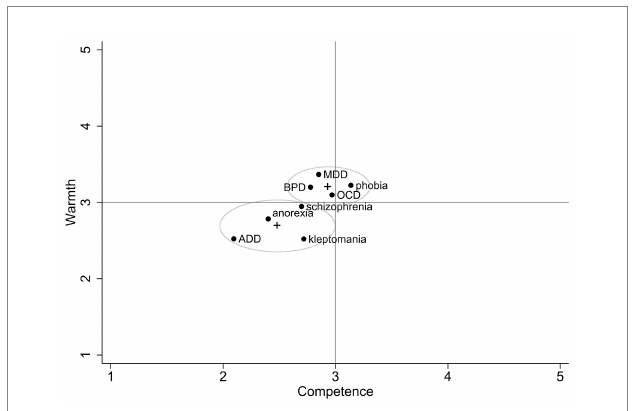
FIGURE 1 Two cluster-solution of different mental disorders within the SCM of the general public.